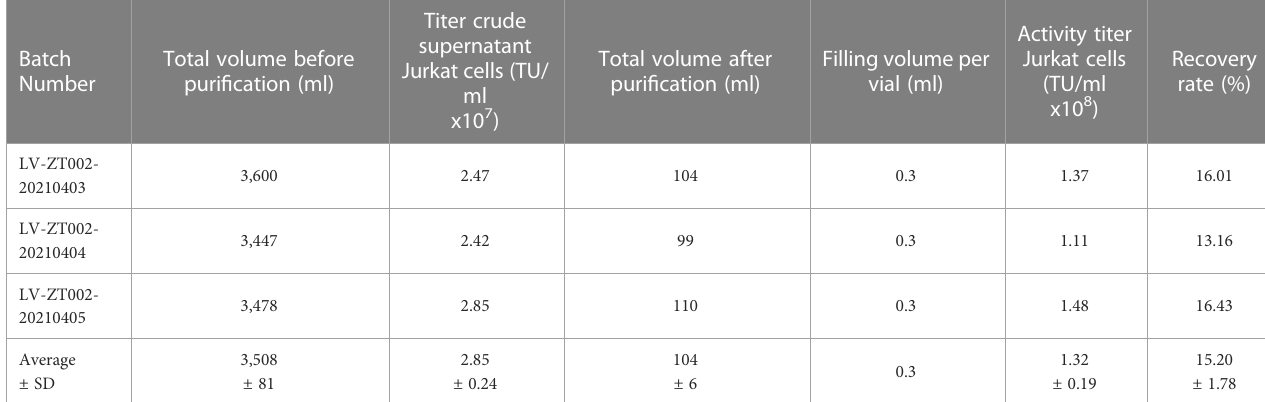
TABLE 1 Validation of LV-ZT002 GMP manufacturing after production and testing of three independent and consecutive viral lots.